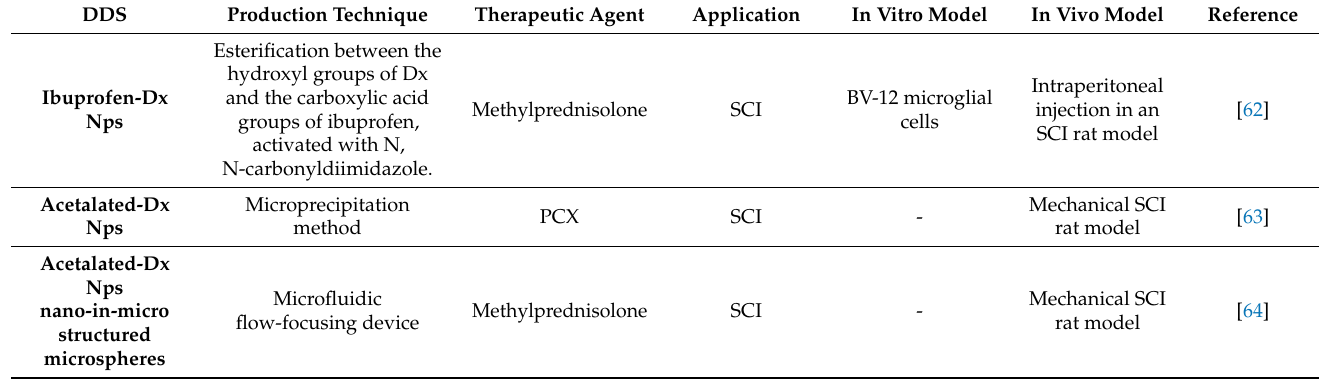
Table 3. Summary of Dx-based DDSs for SCI and PNI application. DDS description, production tech- nique, therapeutic agent delivered, and in vitro and in vivo models exploited for efficacy assessment are